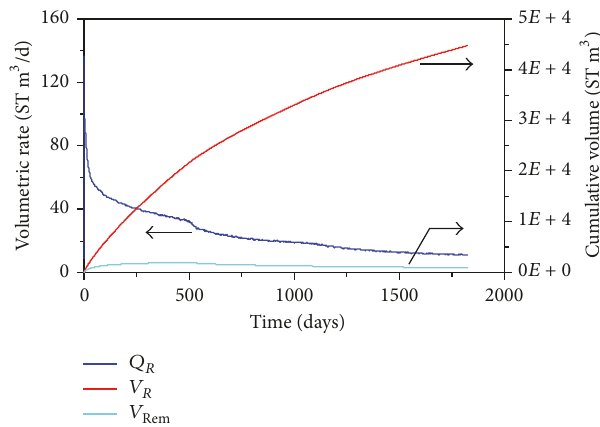
Figure 5: Evaluation of methane release rate ( 𝑄 𝑅 ), the cumulative volume of methane released in the reservoir ( 𝑉 𝑅 ), and the cumula- tive volume of methane remaining in the reservoir ( 𝑉 Rem ) during gas production from horizontal